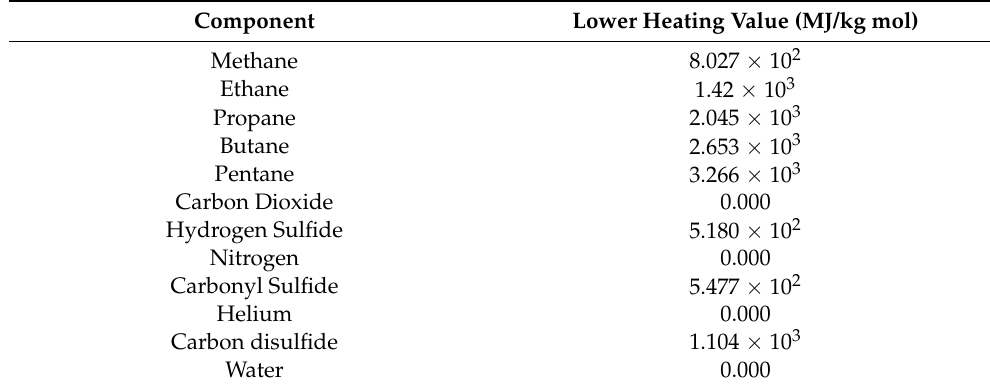
Table 3. Lower heating value per component